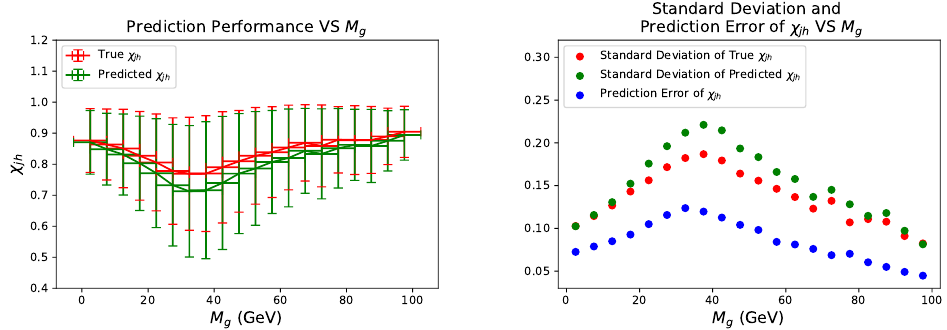
Figure 30 . Prediction Performance (left panel) and Standard Deviation, Prediction Error (right panel) VS M g